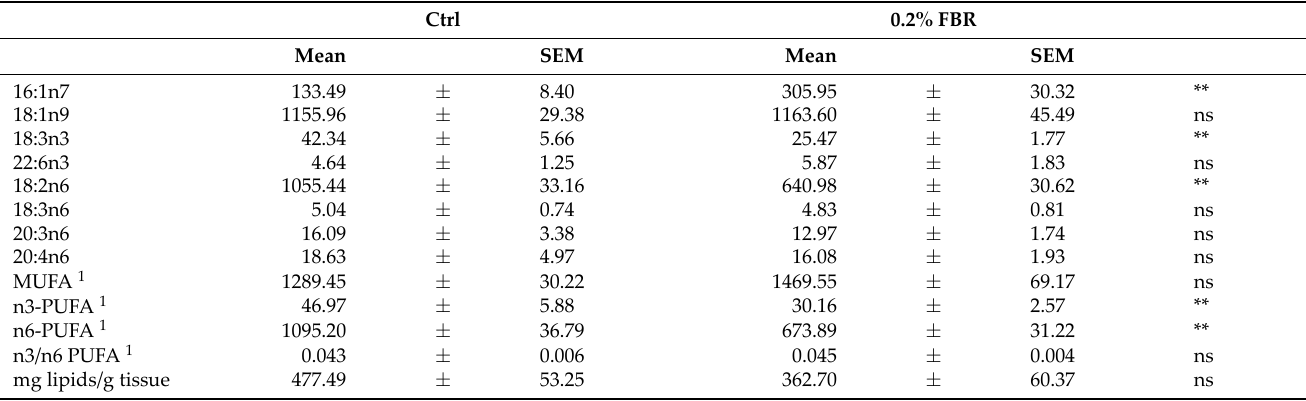
Table 2. Main fatty acids (FA) in visceral adipose tissue (VAT) of mice fed a control diet (Ctrl) or a 0.2% fenofibrate‑supplemented diet (0.2% FBR). Data are expressed as nmoles/mg of lipids and represent the mean ± SEM of n = 5. ** p ≤ 0.01; ns = not significant. Ctrl